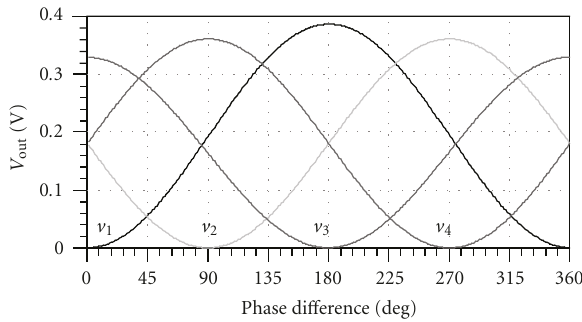
Figure 8: Simulation results of Vout versus inputs phase di ff erence. In order to demonstrate that the multiport is a four “ q i - point” circuit having all points spaced by 90 Æ , a harmonic balance simulation was performed at 60 GHz using a multi- port model based on ADS momentum S parameter results. Power detectors were connected at the four outputs. The phase di ff erence between millimeter-wave inputs was swept in a 360 Æ range and the RF input signal power was set to 0 dBm. The multiport output detected voltages versus the phase di ff erence are shown in Figure